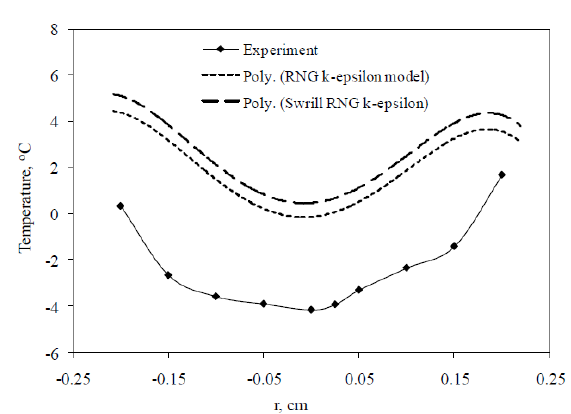
Figure 9. Total velocity vectors along radial direction at 1.5 cm dis- tance from the inlet nozzle towards the hot side of vortex tube at 5 bar absolute inlet pressure.